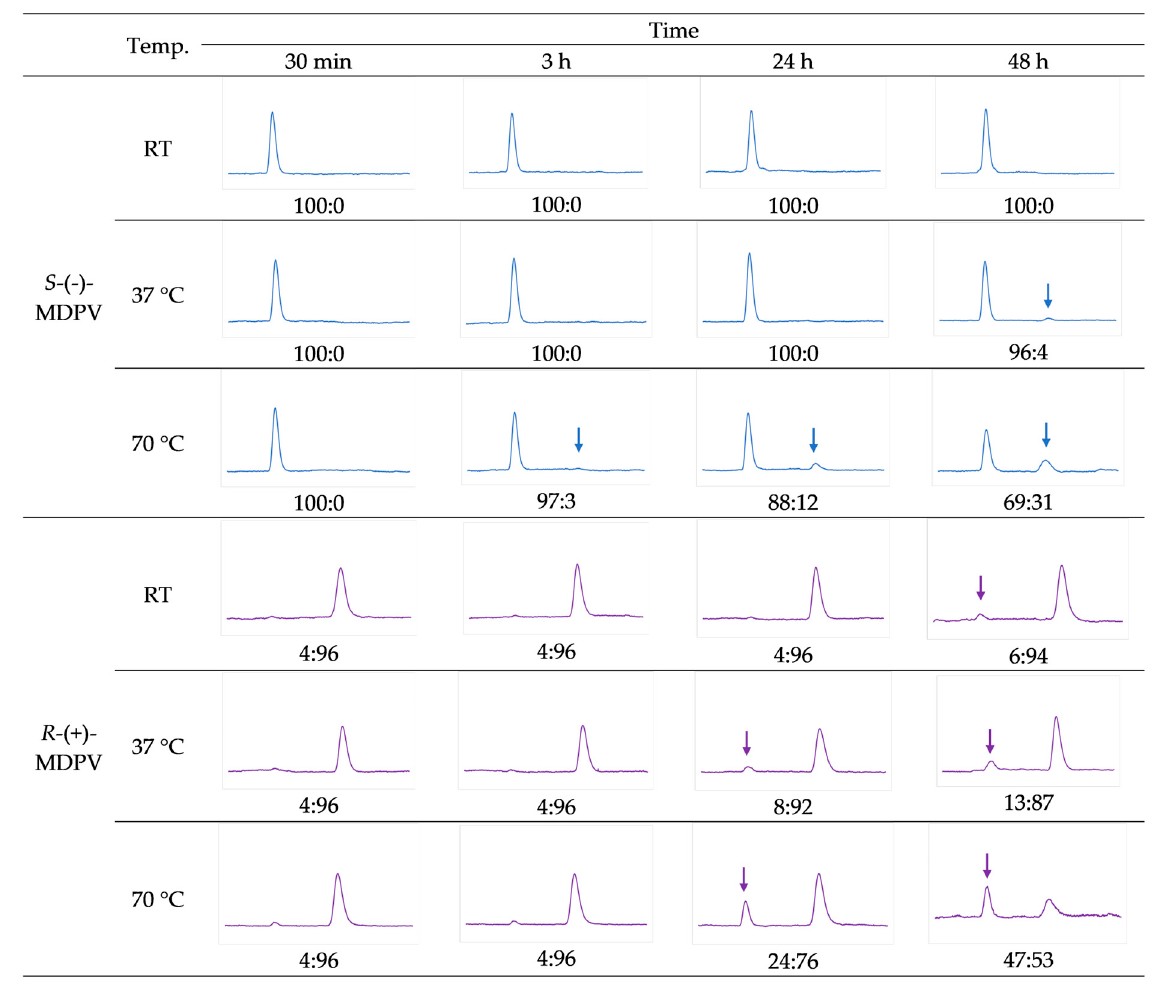
Figure 6. Chromatograms from the racemization study after exposing the enantiomers to different temperatures (RT, 37 °C, and 70 °C), in the absence of DIPEA for 48 h, and respective e.r. values. After analyzing the chromatograms corresponding to S -(-)-MDPV, no signs of racemization were observed for 48 h at RT and 24 h at 37 °C. After exposing S -(-)-MDPV for 48 h to 37 °C, a small peak showed up in the chromatogram with the same t R as R -(+)- MDPV, suggesting that racemization was starting to occur. A change in the e.r. from 100:0 to 96:4 was observed. After 3 h at 70 °C, a change in the e.r. from 100:0 to 97:3 was also observed. The area of S -(-)-MDPV increased after 24 h at 70 °C (e.r. of 88:12) and even more after 48 h